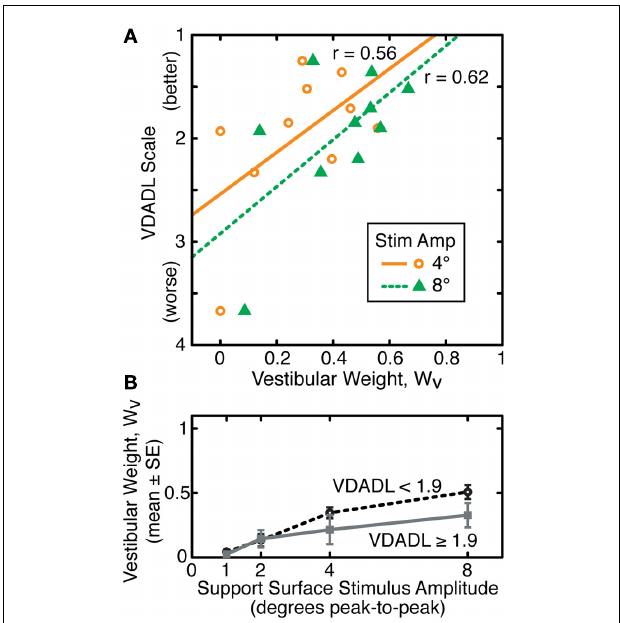
FIGURE 6 | Relationship between vestibular weights ( W V ) and functional status assessed using the vestibular disorders activities of daily living (VDADL) scale for subjects with unilateral vestibular loss. (A) Linear regression and linear correlation coefficients relatingVDADL score and W V are shown for W V values obtained from sway responses to support surface stimuli with 4˚ and 8˚ amplitudes. (B) Segregation of W V data into two sets ( N = 5 in each group) according toVDADL scores demonstrates that unilateral loss subjects with better function (lower VDADL) make greater use of vestibular information for stance control at larger stimulus